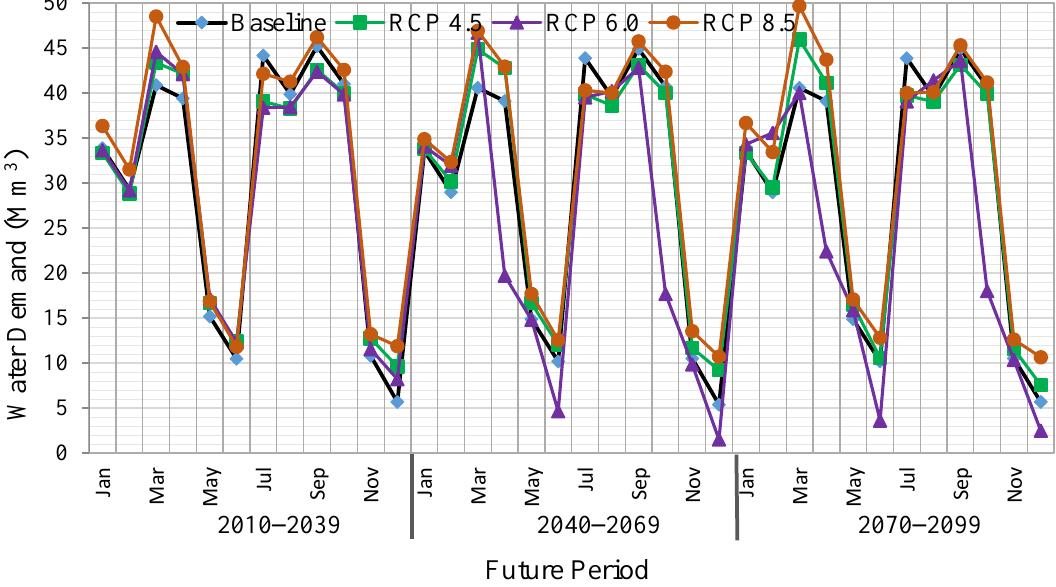
Figure 12. Projected mean monthly water demand from multi-models with three RCP scenarios for future periods of 2010–2039, 2040–2069, and 2070–2099 relative to baseline period of 1976–2005.